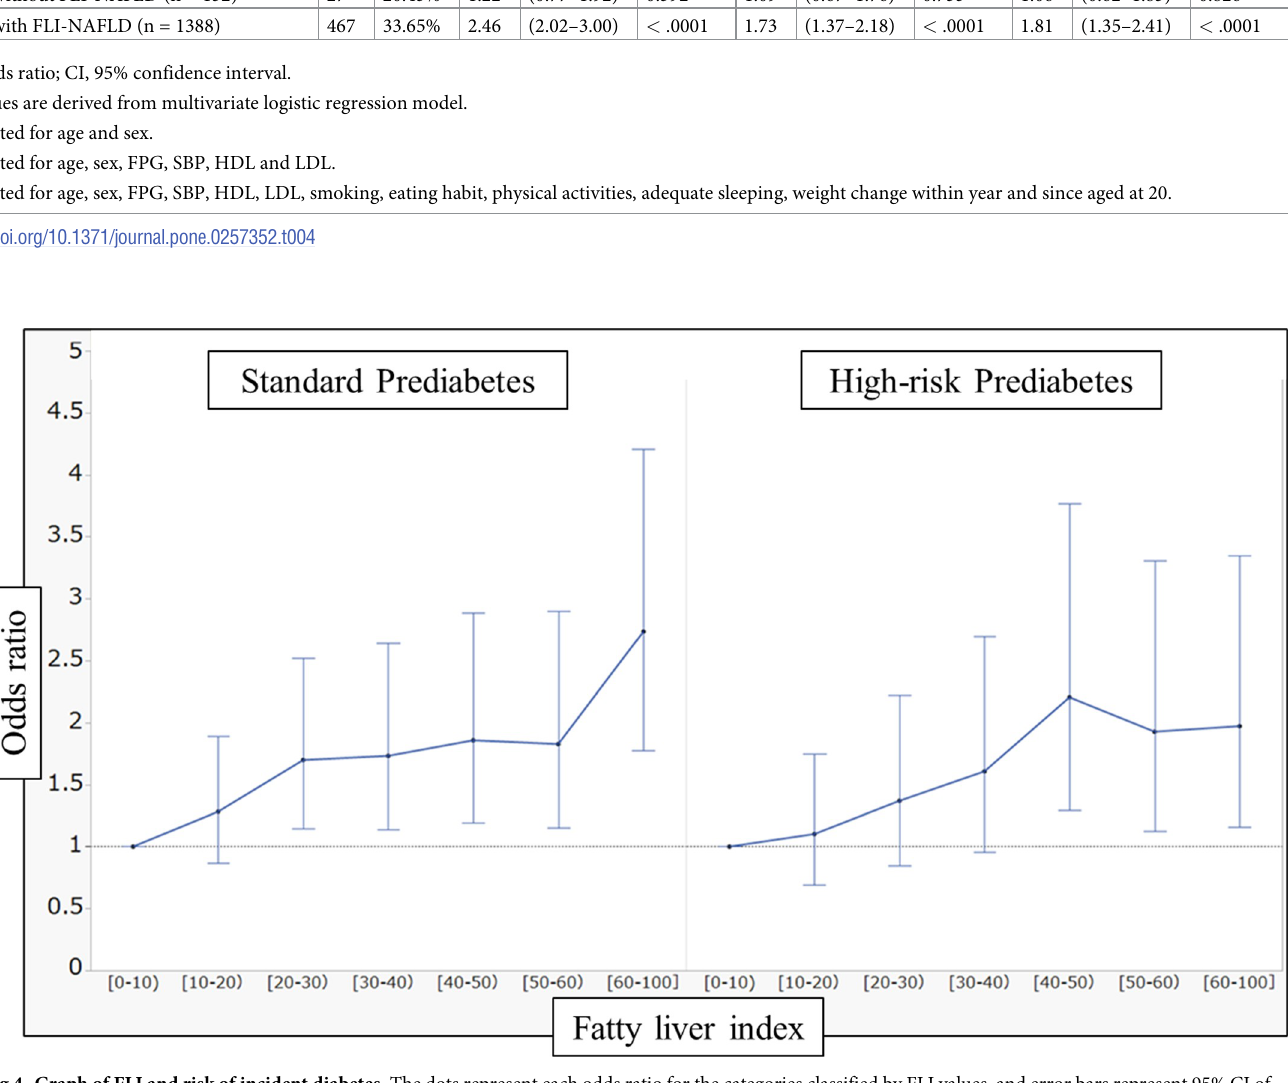
Fig 4. Graph of FLI and risk of incident diabetes. The dots represent each odds ratio for the categories classified by FLI values, and error bars represent 95% CI of the odds ratio.